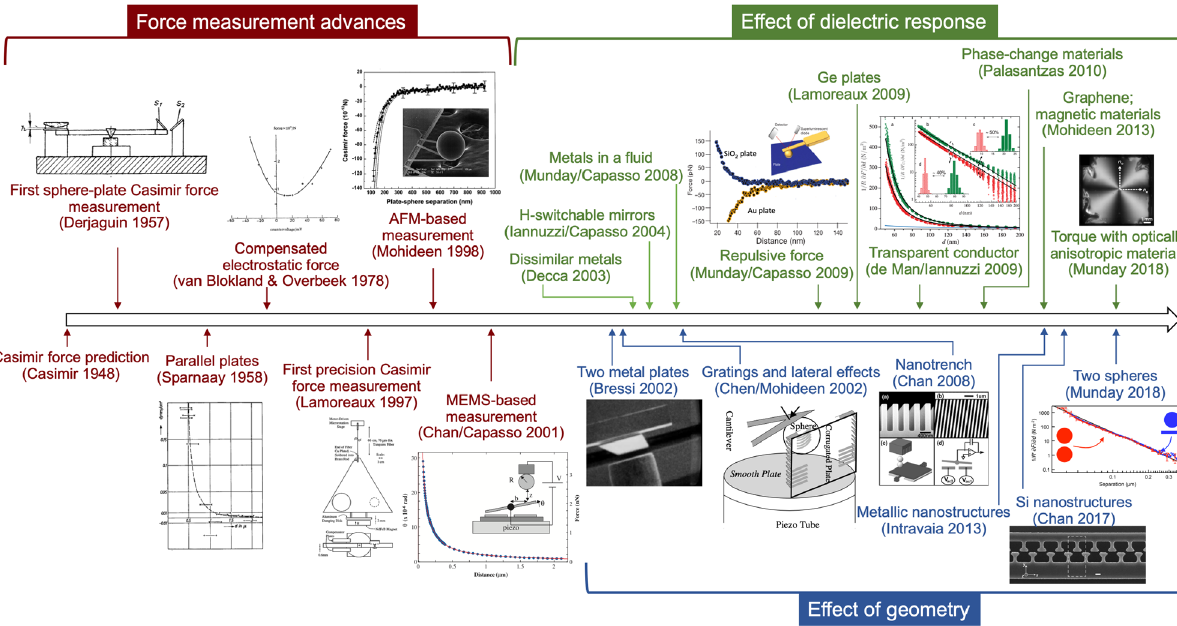
Figure2: AbriefhistoryofCasimirforcemeasurementsandtheuseofdielectricresponseandgeometrytomodifytheinteraction.Theimages in this chart are adapted with permission from the studies by Abrikosova and Derjaguin [6]. Copyright 1957, MAIK